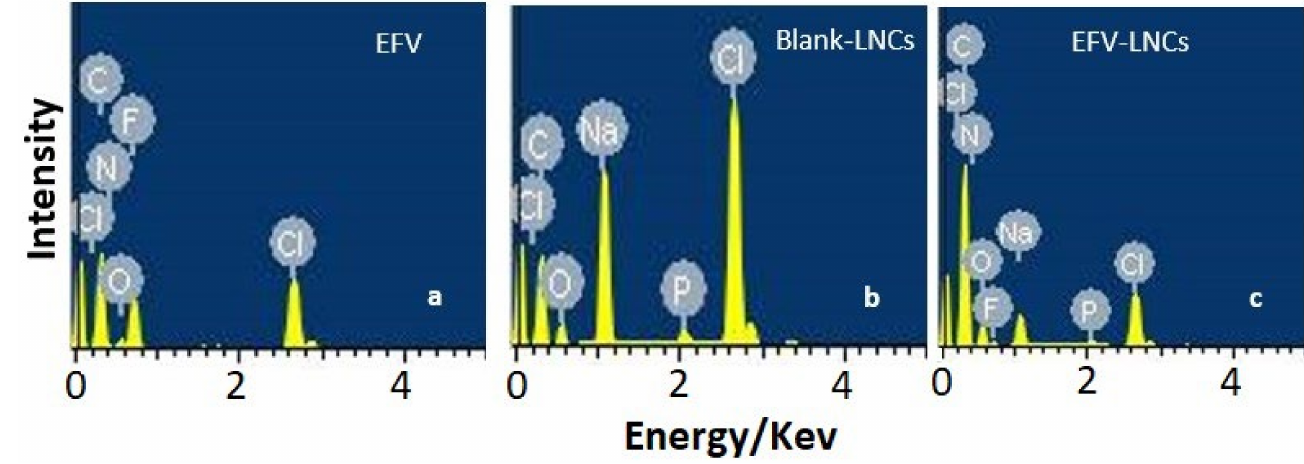
Figure 10. EDS spectra illustrating the elemental composition of free efavirenz ( a ) and LNC formulations ( b , c